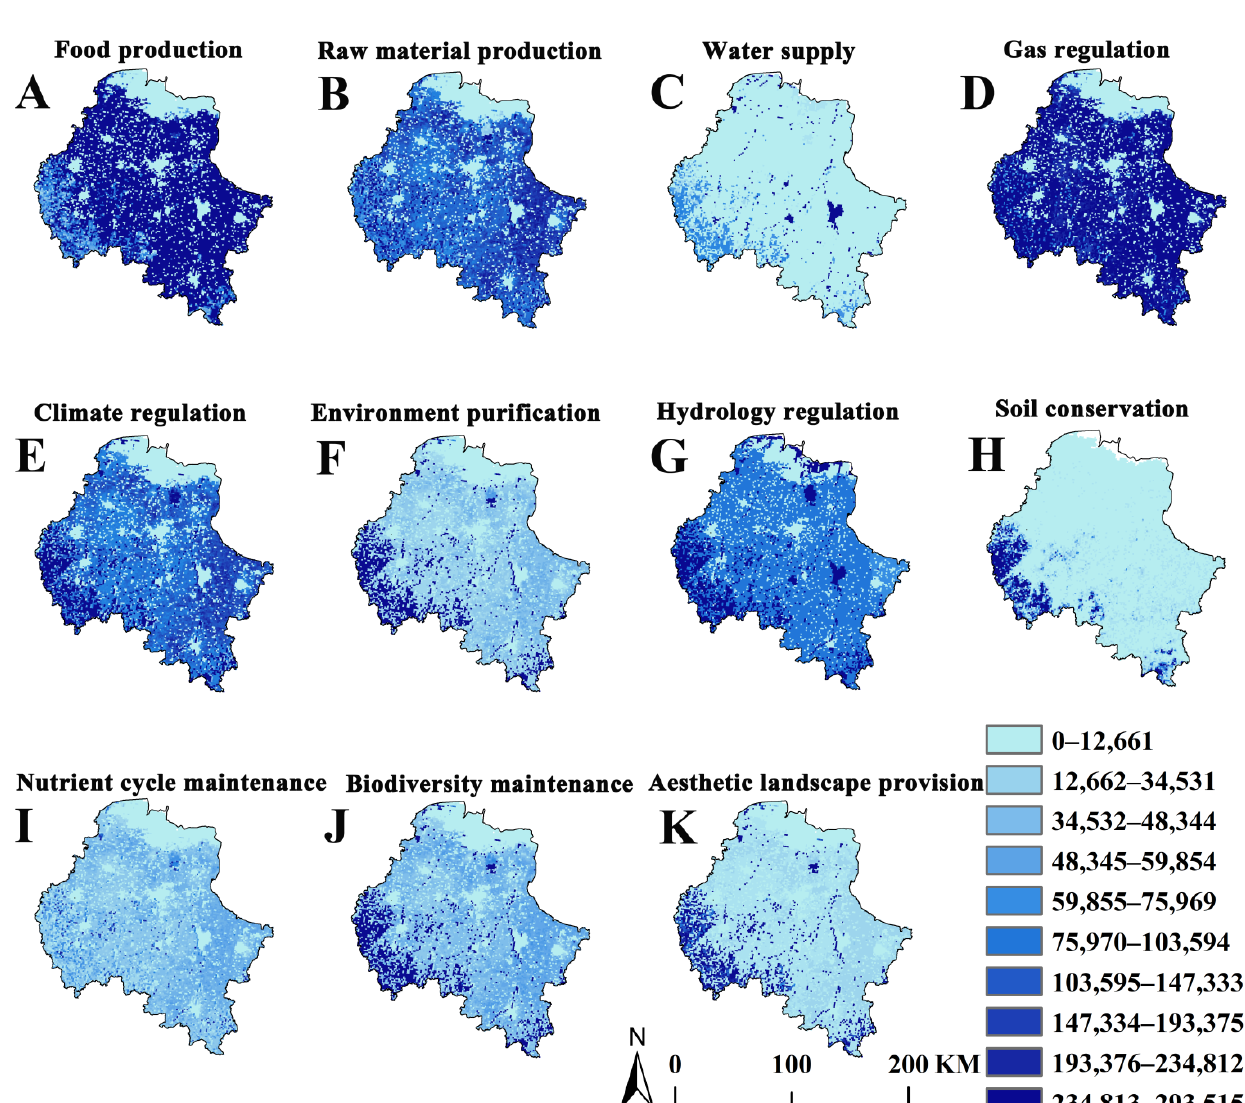
Figure 3. Spatial variations in ecosystem service subtypes (yuan/km 2 ).